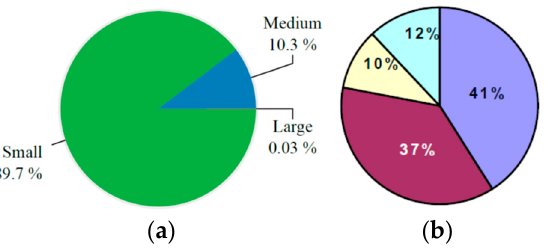
Figure 1. The breakdown of global motor usage by size ( a ) [1], and distribution of common faults of electric motors ( b ) according to EPRI survey results [2].